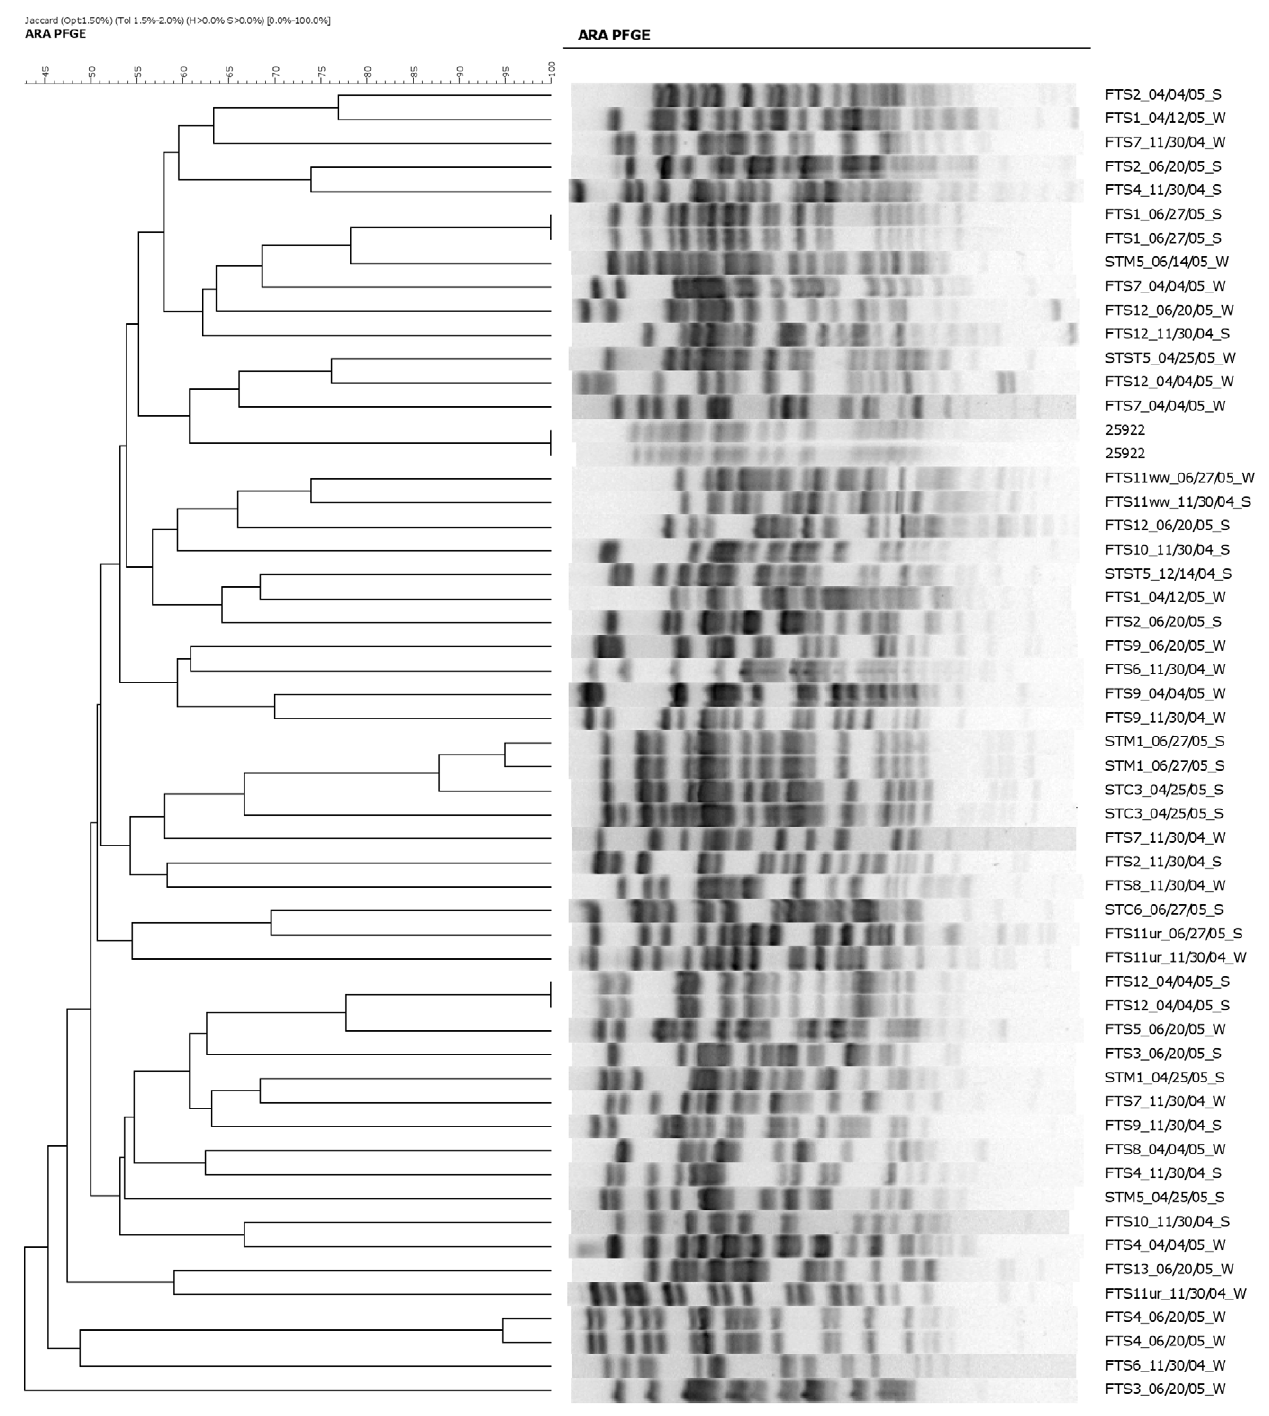
Figure 5. Representative PFGE fragment patterns and dendrogram analysis of unique E.coli isolates obtained from surface water and sediment showing diversity and stability of isolates.